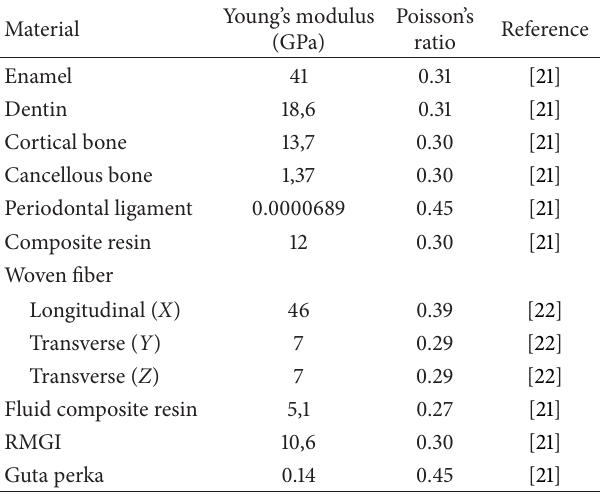
Table 1: Material properties (Young’s modulus and Poisson’s